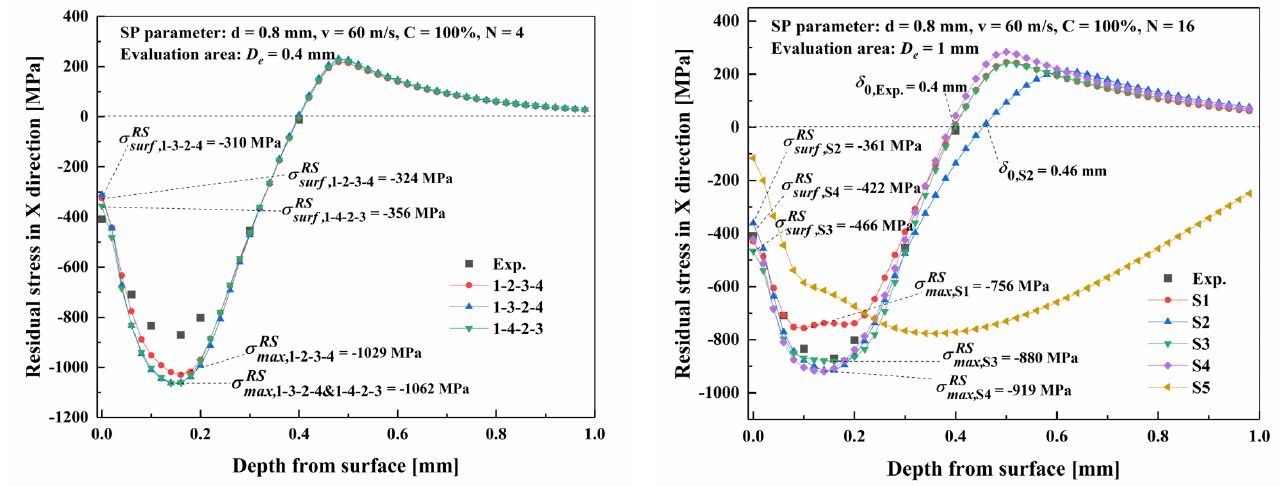
Figure 11. The residual stress depth profiles after ( a ) 4 shots and ( b ) 16 shots impact the workpiece with different impact sequences.